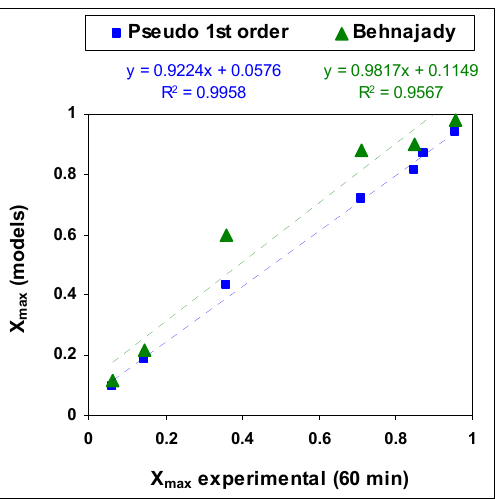
Figure 6. Relationship between experimental maximum conversions (obtained at sixty minutes) and models (pseudo-first order and Behnajady) maximum conversions.